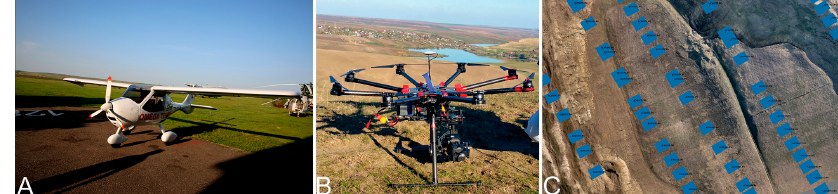
Figure 4. ( A ) Ultra-light aircraft used for the air surveys; ( B ) Octocopter with GPS module and gimbal hanging from the main platform; ( C ) The spatial distribution of the air photographs taken from the UAV.